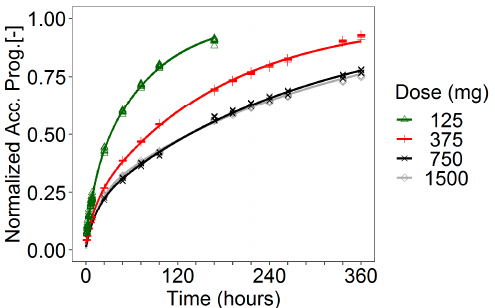
Table A3. Absolute %PEs on C max for IVIVC P-ring model identified on dose 125, 750, and 1500 mg.